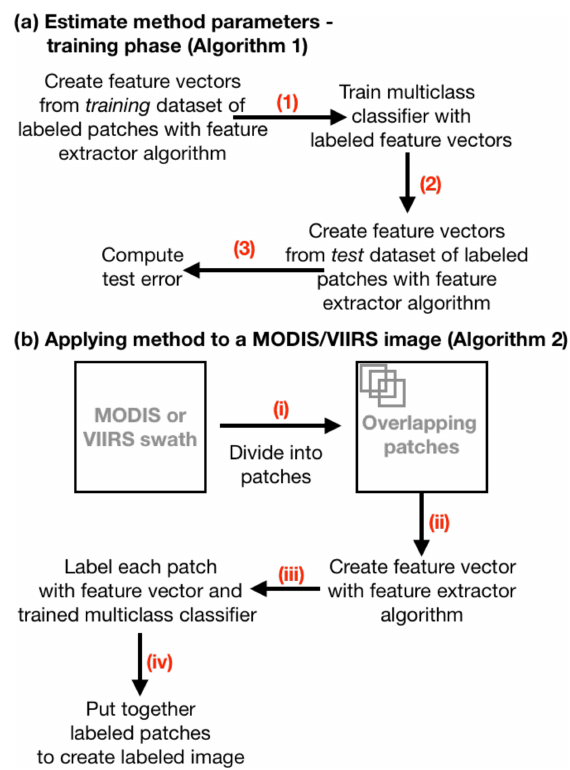
Figure 3. A method that identifies cloud types and aerosols in MODIS–VIIRS images consists of a feature extractor (FE) algo- rithm and a multiclass classifier. (a) The parameters of the method’s multiclass classifier are estimated and the test error is computed by (1) creating the feature vectors from each patch in the training dataset via the method’s FE algorithm, (2) estimating the multiclass classifier’s parameters using the training feature vectors and the cor- responding labels, and (3) extracting the feature vectors from each patch in the test dataset and computing the test error from the test feature vectors and corresponding labels. (b) A trained method is applied to a MODIS or VIIRS image by (i) dividing the MODIS or VIIRS image into overlapping patches, (ii) extracting for each patch the spatial texture feature vectors via the method’s FE algorithm, (iii) labeling each patch via the feature vector and the method’s trained multiclass classifier, and (iv) putting together all the labeled patches to create a labeled